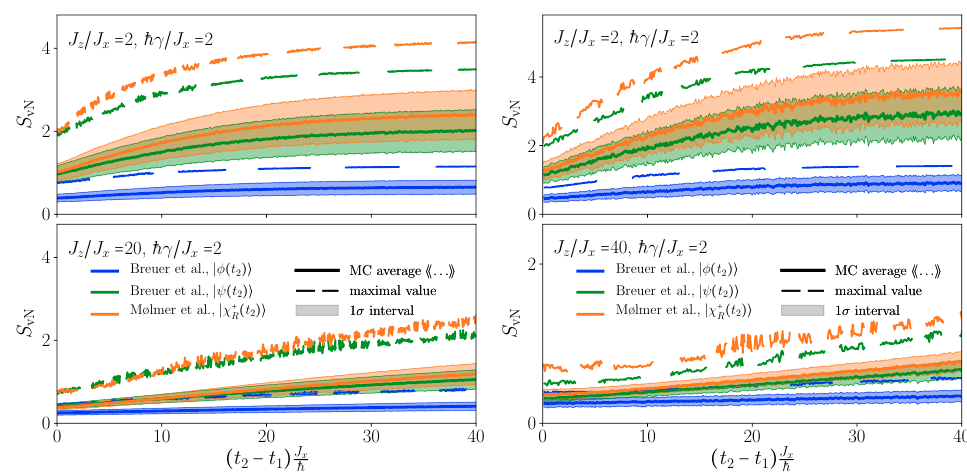
Figure 9: Evolution of the von Neumann entropy as a resource measure for different branches of Breuer and Mølmer MCWF approach to computing two-time correlation functions for two different sets of model parameter. Results are shown for t / (cid:126) = 0.02 and 10 4 trajectory samples for (left panel) an exact a time step of ∆ tJ x MPS representation with chains of length L = 14 and (right panel) non-exact MPS representation for L =